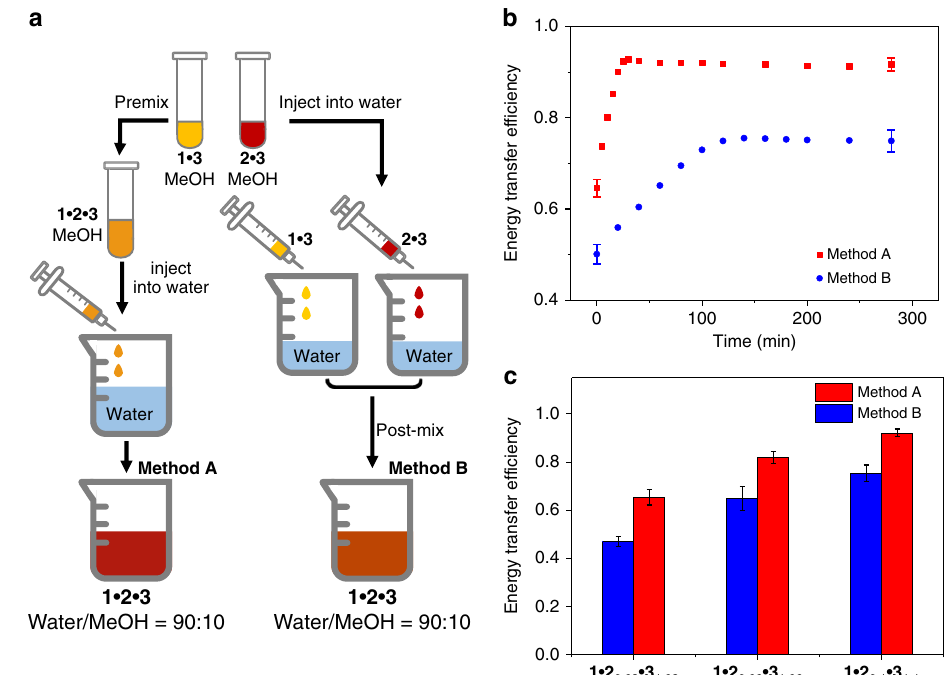
Fig. 7 Characterization of energy transfer dynamics of 1 (cid:129) 2 (cid:129) 3 . a Schematic illustration of two preparation methods toward the ternary complex 1 (cid:129) 2 x (cid:129) 3 (1 + x ) . b Time dependence of energy transfer ef fi ciency for complex 1 (cid:129) 2 0.1 (cid:129) 3 1.1 . c Energy transfer ef fi ciency for complexes 1 (cid:129) 2 0.03 (cid:129) 3 1.03 , 1 (cid:129) 2 0.06 (cid:129) 3 1.06 , and 1 (cid:129) 2 0.1 (cid:129) 3 1.1 , by employing the two different preparation methods [ 1 : 5.00 × 10 − 5 M in water/MeOH (90:10, v / v )]. All error bars represent s.e.m. from triplicate independent